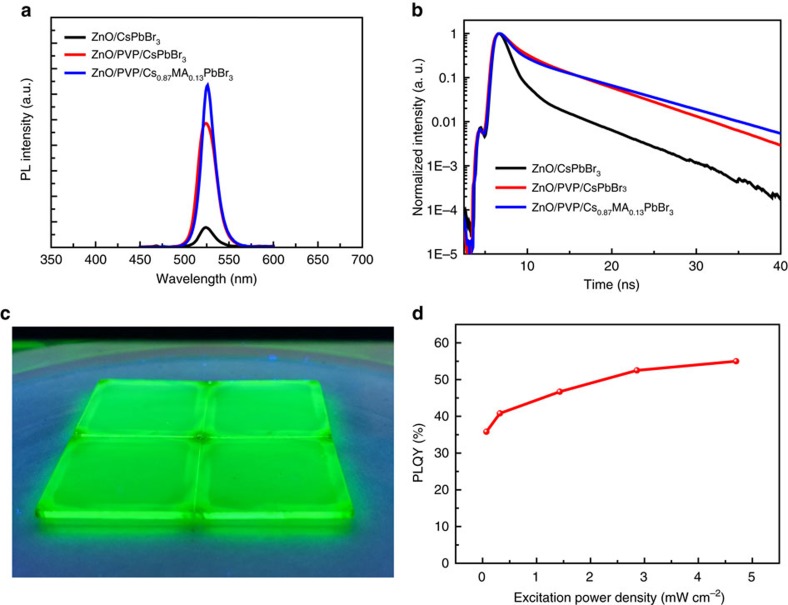
PL behaviour of CsPbBr3 films deposited under different conditions.(a) Steady-state PL of CsPbBr3 films on ZnO, ZnO/PVP and Cs0.87MA0.13PbBr3 film on ZnO/PVP, respectively, here PVP is polyvinyl pyrrolidine, MA is CH3NH3. (b) Time-resolved PL of CsPbBr3 films on ZnO and ZnO/PVP and Cs0.87MA0.13PbBr3 on ZnO/PVP. (c) PL image of Cs0.87MA0.13PbBr3 films on ZnO/PVP under ultraviolet lamp excitation. (d) PLQY of Cs0.87MA0.13PbBr3 as a function of excitation power density.